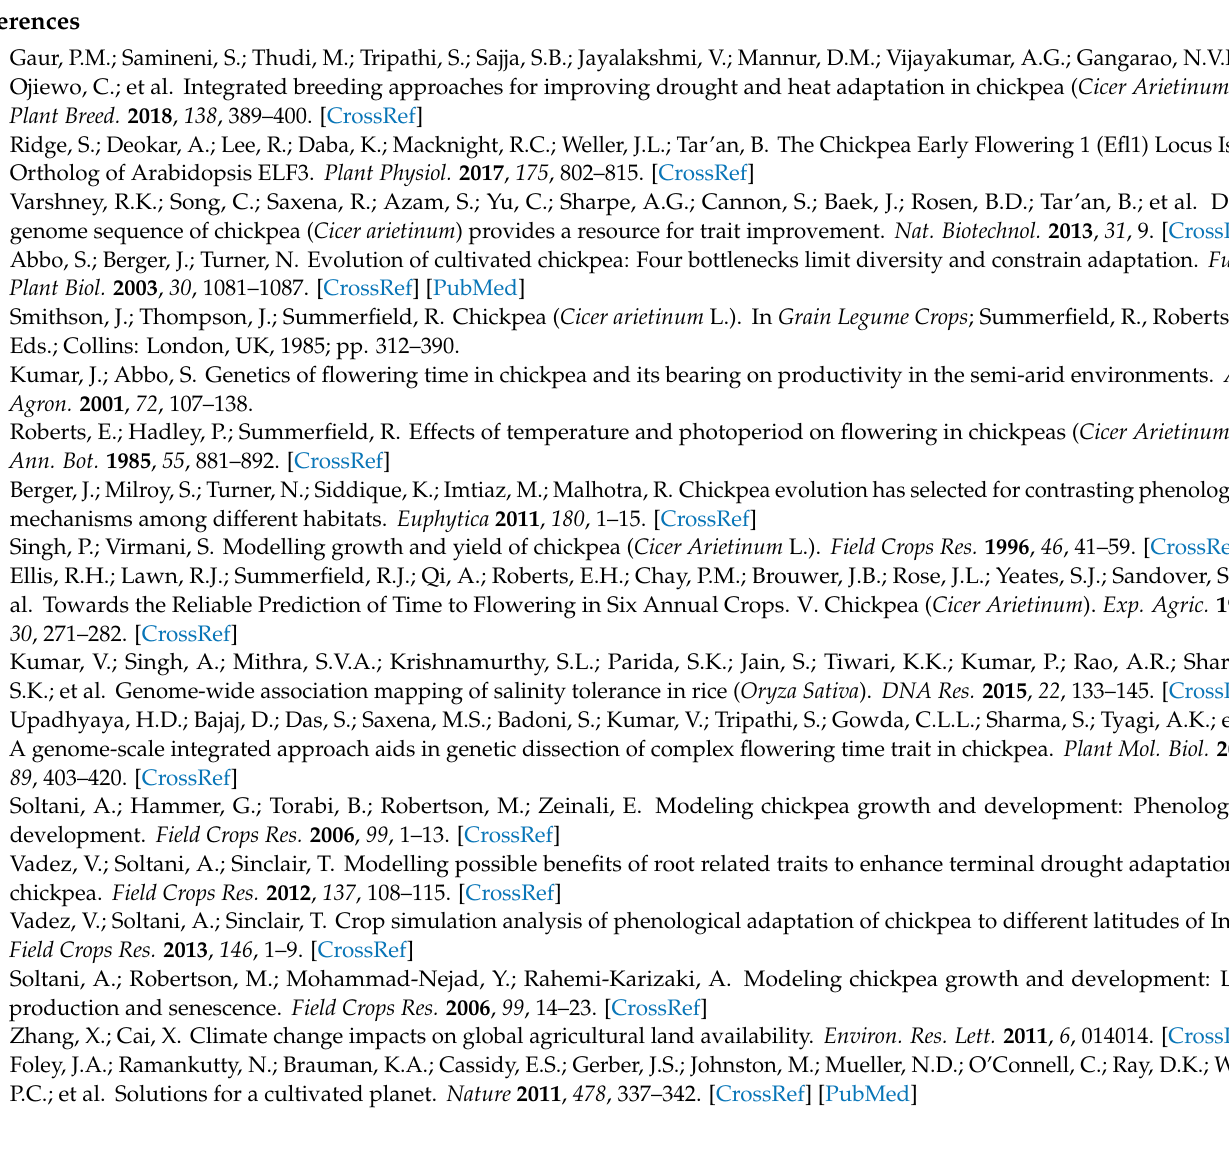
Table S8: Coefficients of 8 functions in ensemble, Table S9: Pearson’s correlation coefficient between climatic